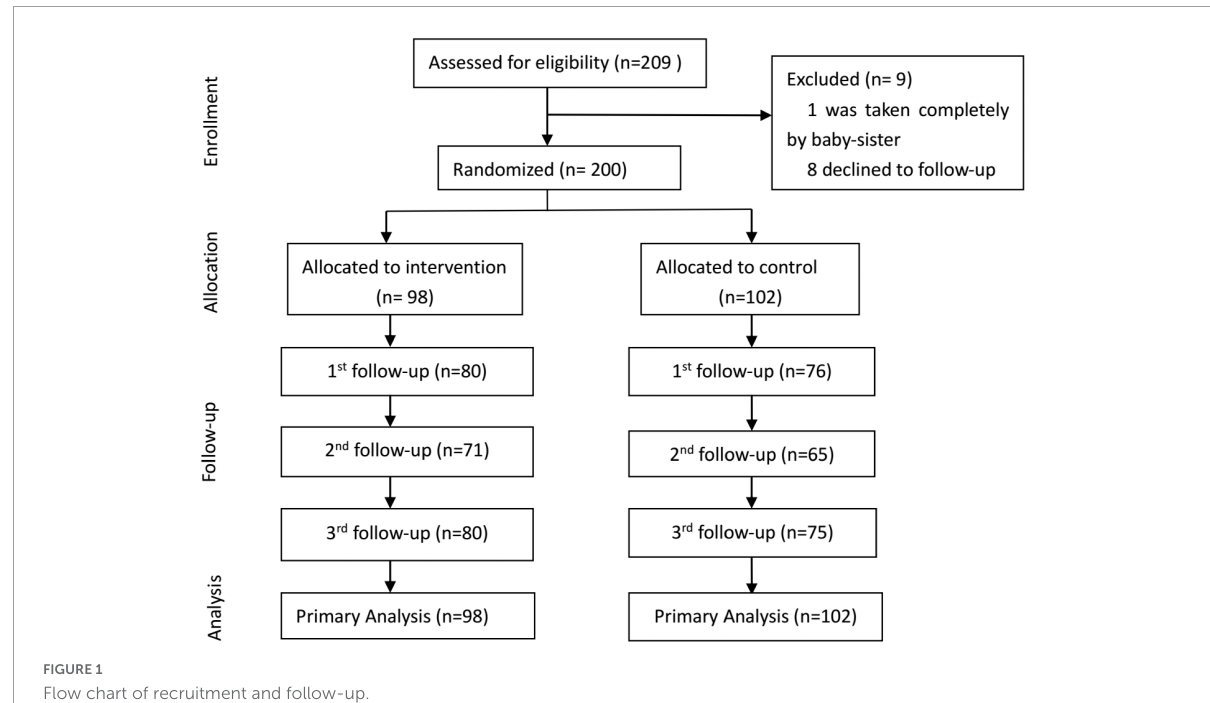
FIGURE1 Flow chart of recruitment and follow-up.